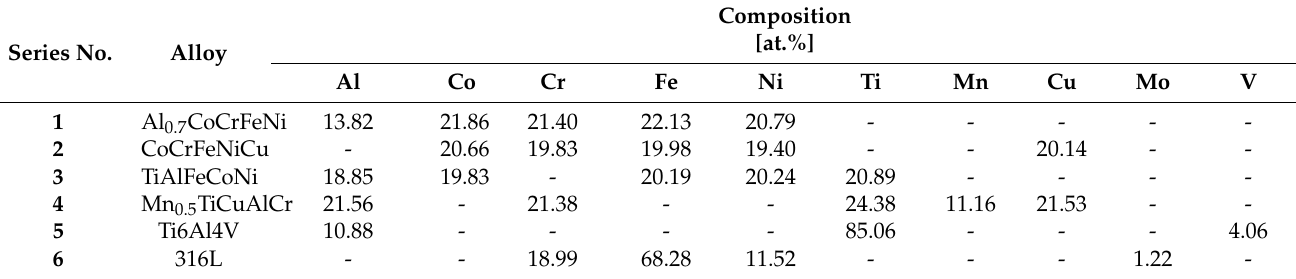
Table 1. SEM Energy-Dispersive X-ray Spectroscopy (EDS) chemical compositions (at.%) of investi- gated